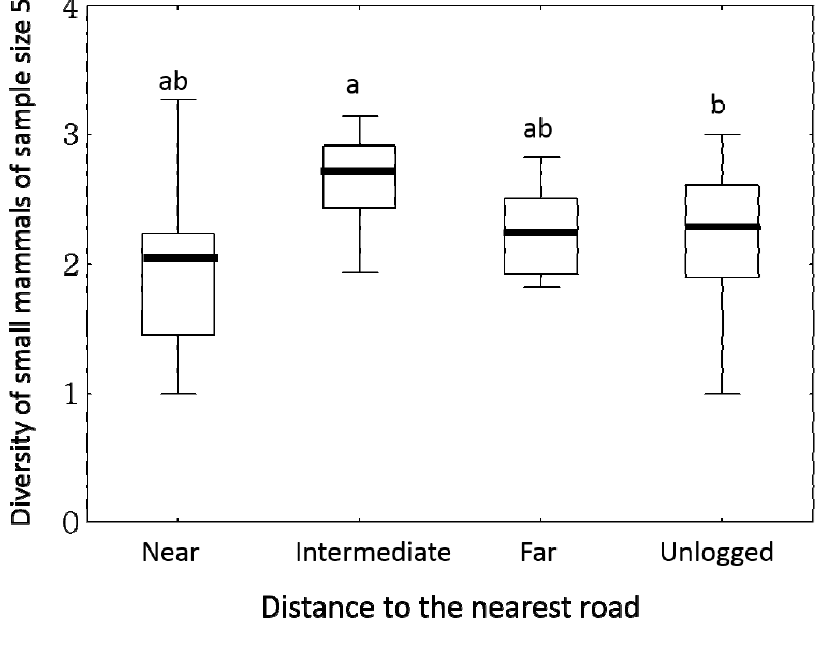
Figure 6. Diversity measured by rarefaction index for small mammals trapped by cameras for distance classes, near (distance from logging road ( D ) < 100 m), intermediate (100 m ≤ D < 200 m), and far ( D ≥ 200 m) from the logging road in the logged forest in the Temengor Forest Reserve. The diversity of small mammals in unlogged forest is also shown (unlogged). Data are shown with a median value (thick black line), 25th and 75th percentiles (upper and lower boundary of box) and maximum and minimum values (whiskers). Boxes labeled with different letters differ significantly among sites ( p < 0.05, Pairwise Wilcoxon Test with Holm